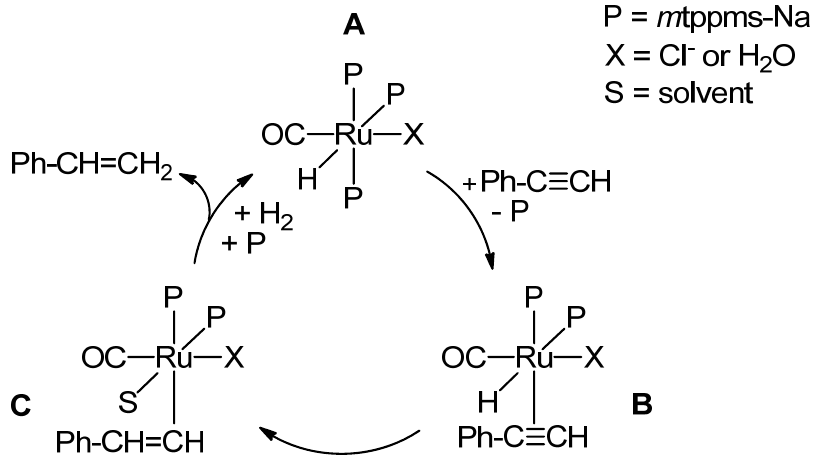
Figure 7. Suggested catalytic cycle of phenylacetylene hydrogenation catalyzed by [RuHCl(CO)( m tppms ‐ Na) 3 ], 1 , or [RuH(H 2 O)(CO)( m tppms ‐ Na) 3 ] + , 2 . ( m tppms-Na) 3 ], 1 , or [RuH(H 2 O)(CO)( m tppms-Na) 3 ] + , 2